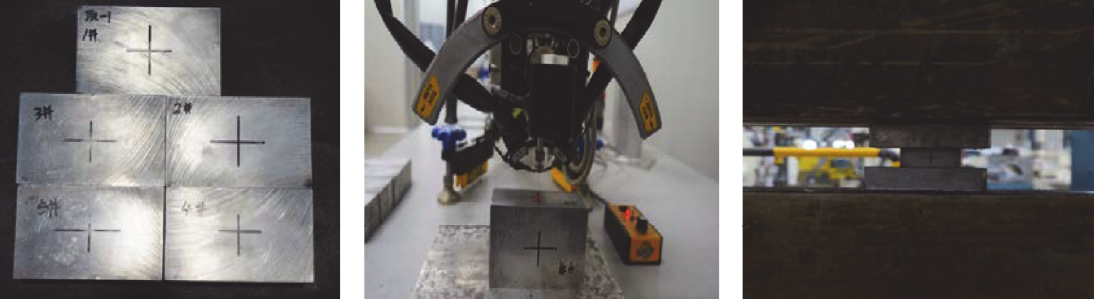
Figure 7: Experimental specimens and equipment.